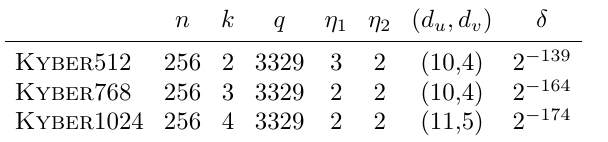
Algorithm 4 Sampling from CBD η : B 64 η → R 3329 as used in